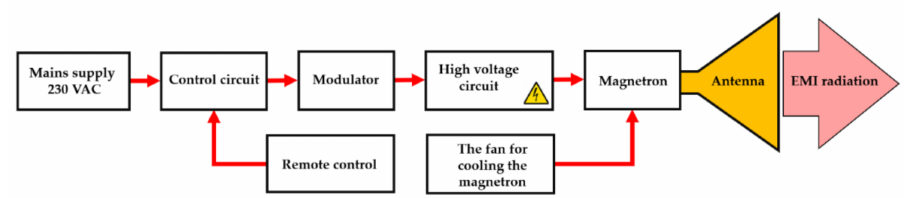
Figure 5. Block diagram of an optimized microwave power generator.